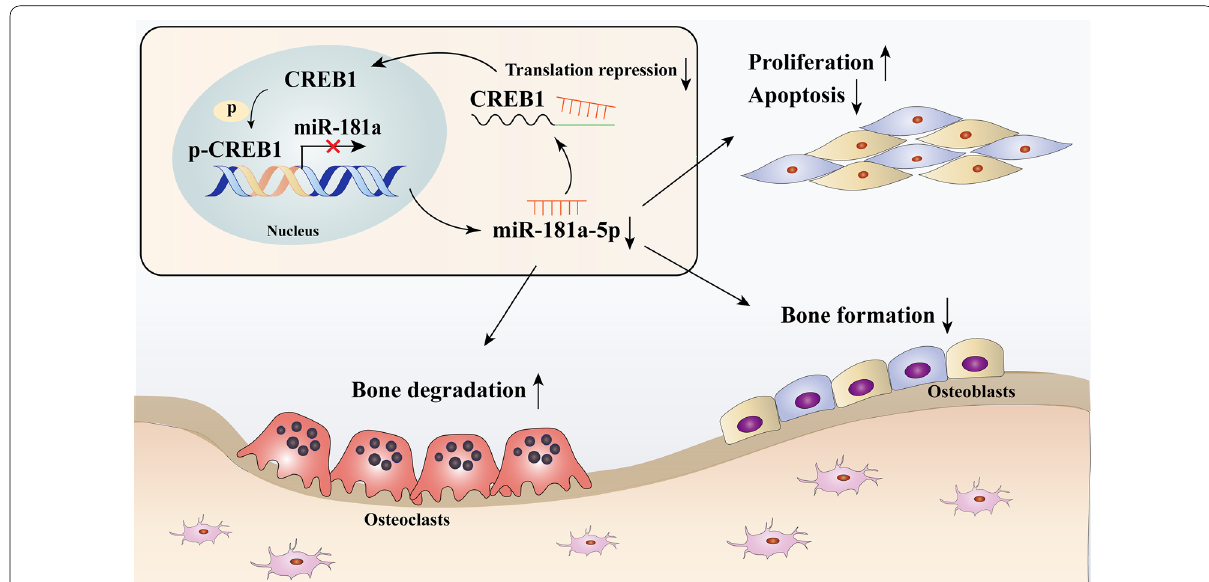
Fig. 6 The CREB1-miR-181a-5p loop in BMSCs from FD lesions. Overproduction of cAMP promotes CREB1 phosphorylation, and p-CREB1 binds to the CRE in the miR-181a promoter to suppress its transcription. Downregulation of miR-181a-5p leads to enhanced proliferation ability, decreased apoptotic capacity, and impaired osteogenic differentiation of FD BMSCs and increases the osteoclast differentiation potential, resulting in clinicopathological features of FD. Moreover, downregulation of miR-181a-5p promotes CREB1 expression by decreasing the inhibition of its translation and further exacerbates pathological manifestations of